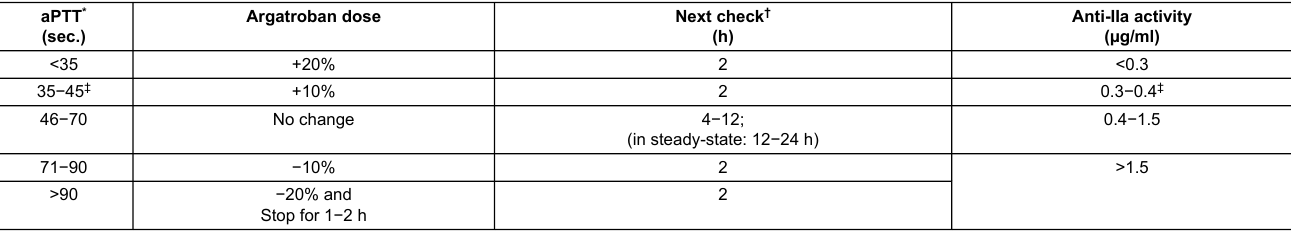
Table 4: Argatroban monitoring with aPTT and/or anti-IIa activity. aPTT *